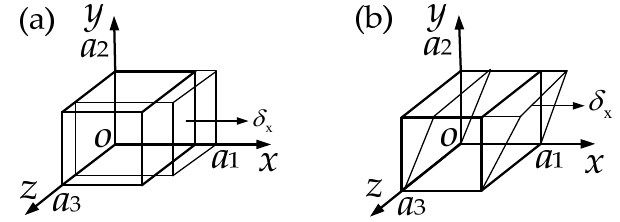
Figure 6. Two load cases for unit cells: ( a ) normal load: tension in x direction; and ( b ) shear load: shear in x ‐ y plane.